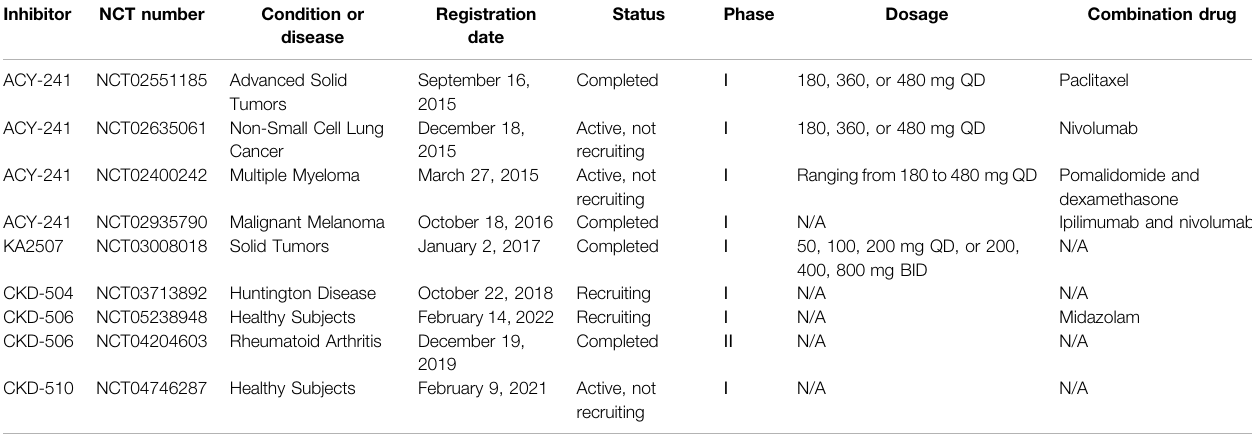
TABLE 2 | Other HDAC6 inhibitors in clinical trials.